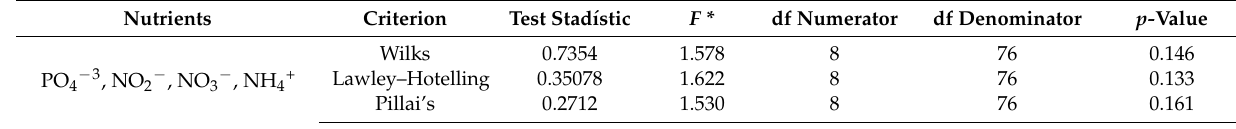
Table 5. Multiple analysis of variance (MANOVA), with a two level factor, artificial wetland habitats with seawater (control) during a 112 d period (Phase 2, 3) ( p > 0.05). Nutrients